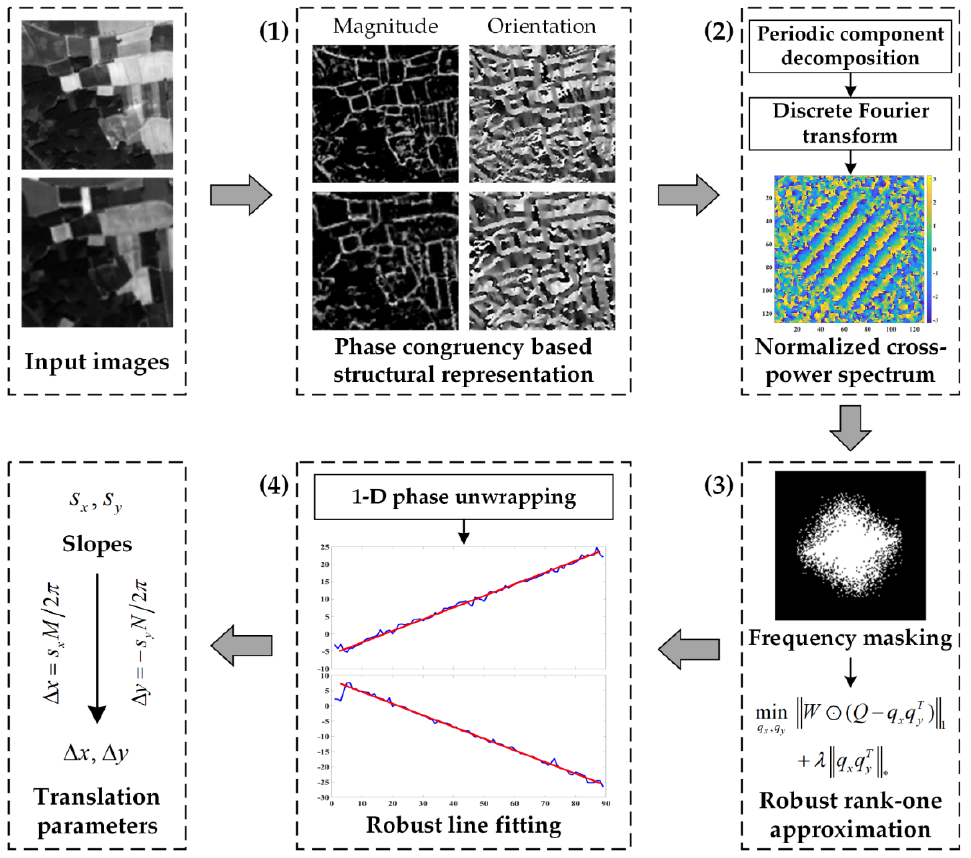
Figure 1. Overall workflow of the enhanced subpixel phase correlation method.